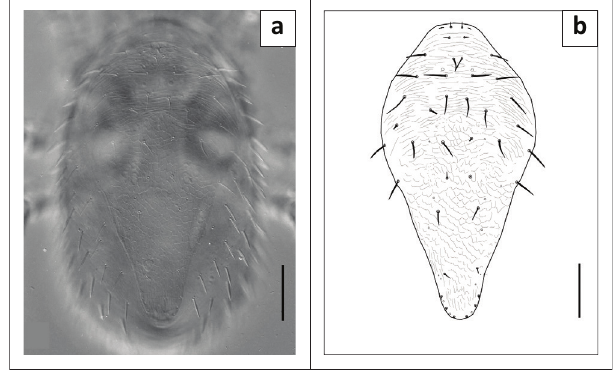
FIGURE 1: Parasteatonyssus nyctinomi , ♀ : (a) photograph, dorsal view; (b) drawing, dorsal shield. Scale bar: 100 μ m.